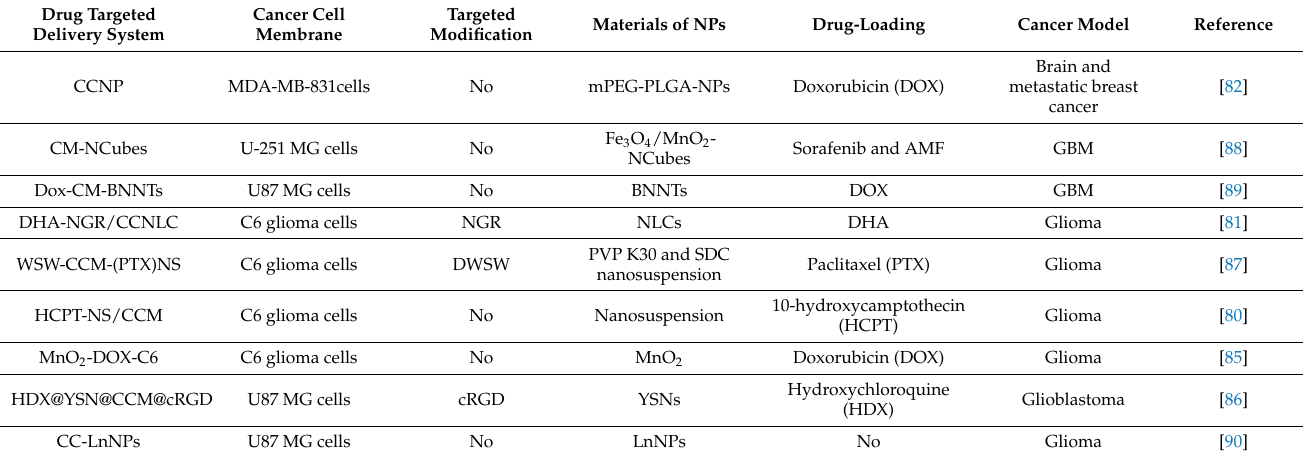
Table 2. Summary of cancer-cell-membrane-coated nanoparticles for ND drug delivery. Drug Targeted Cancer Cell Delivery System